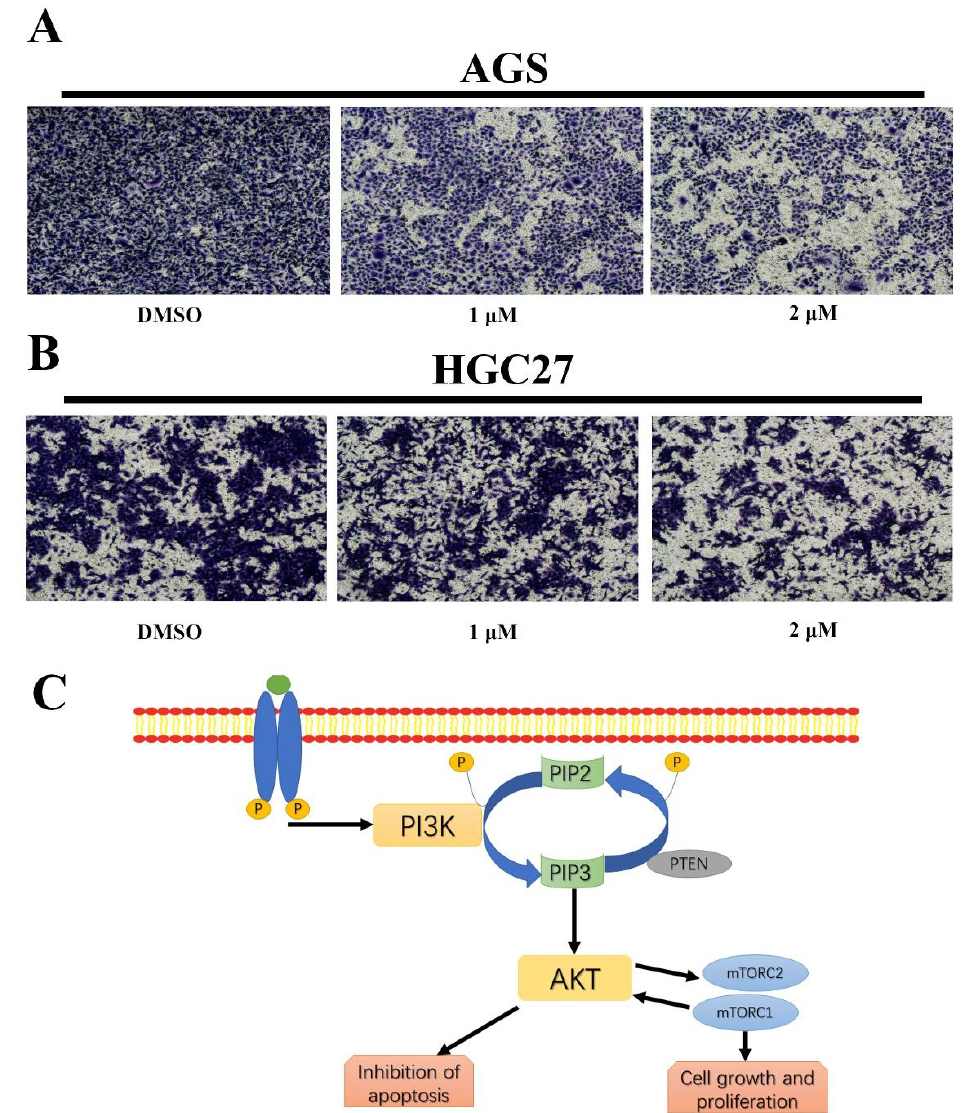
Figure 8. The effects of BLG26 on cell migration and PI3K/AKT/mTOR signal pathway. ( A ) Transwell assay showed that cell migration of AGS was inhibited by BLG26. ( B ) Transwell assay showed that cell migration of HGC27 was inhibited by BLG26. ( C ) PI3K/AKT/mTOR signal path- way.